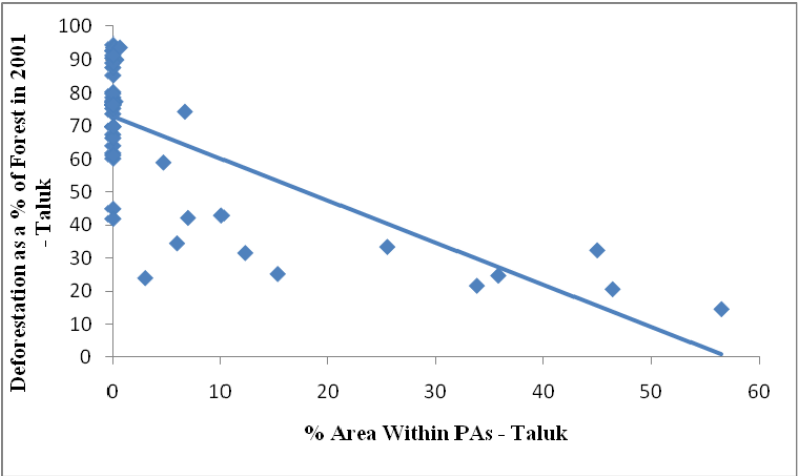
Figure 16b. Relationship between percentage of area within PAs and the distribution of deforestation as a percentage of the forest area existing in 2001, for